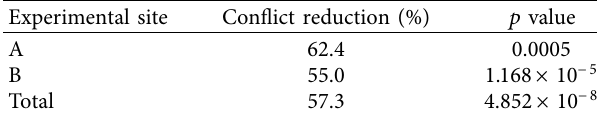
Table 4: Trafc confict reduction (safety